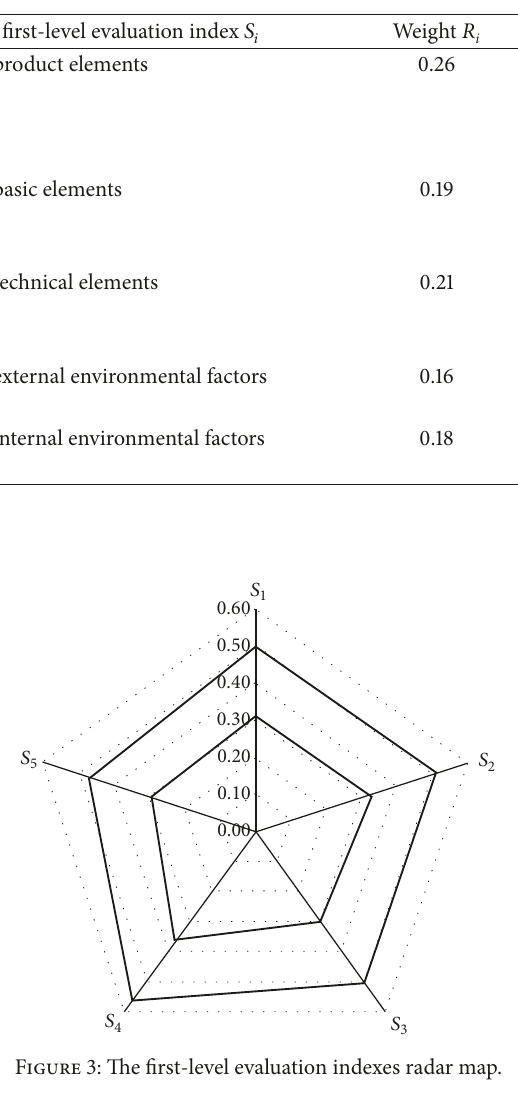
Table 2: Enterprise product quality evaluation indexes and its weight.